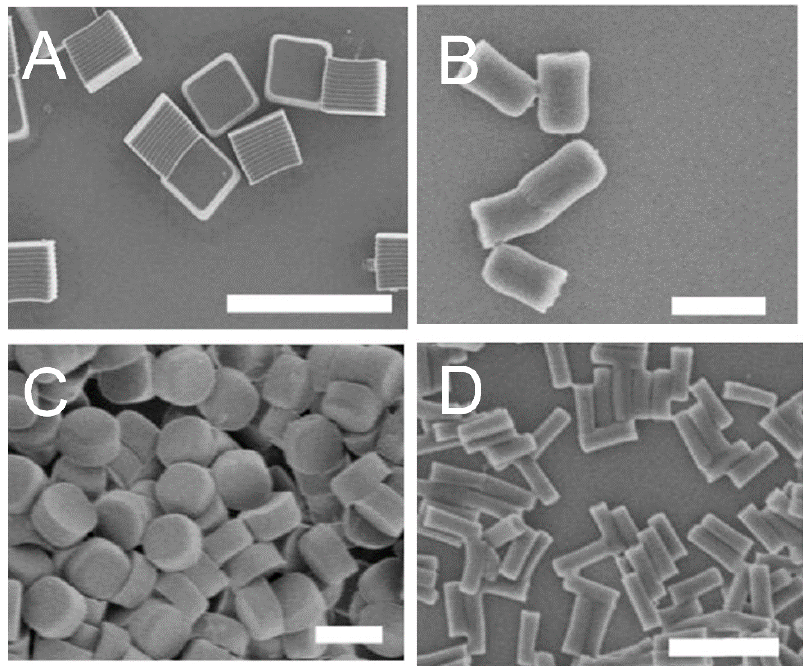
Figure 7. Micrographs of PRINT particles varying in both size and shape. The scale bars for ( A ) is 20 μ m; ( B – D ) is 1 μ m. (Reproduced with permission from Reference [103], Copyright (2008) National Academy of Sciences, U.S.A.).